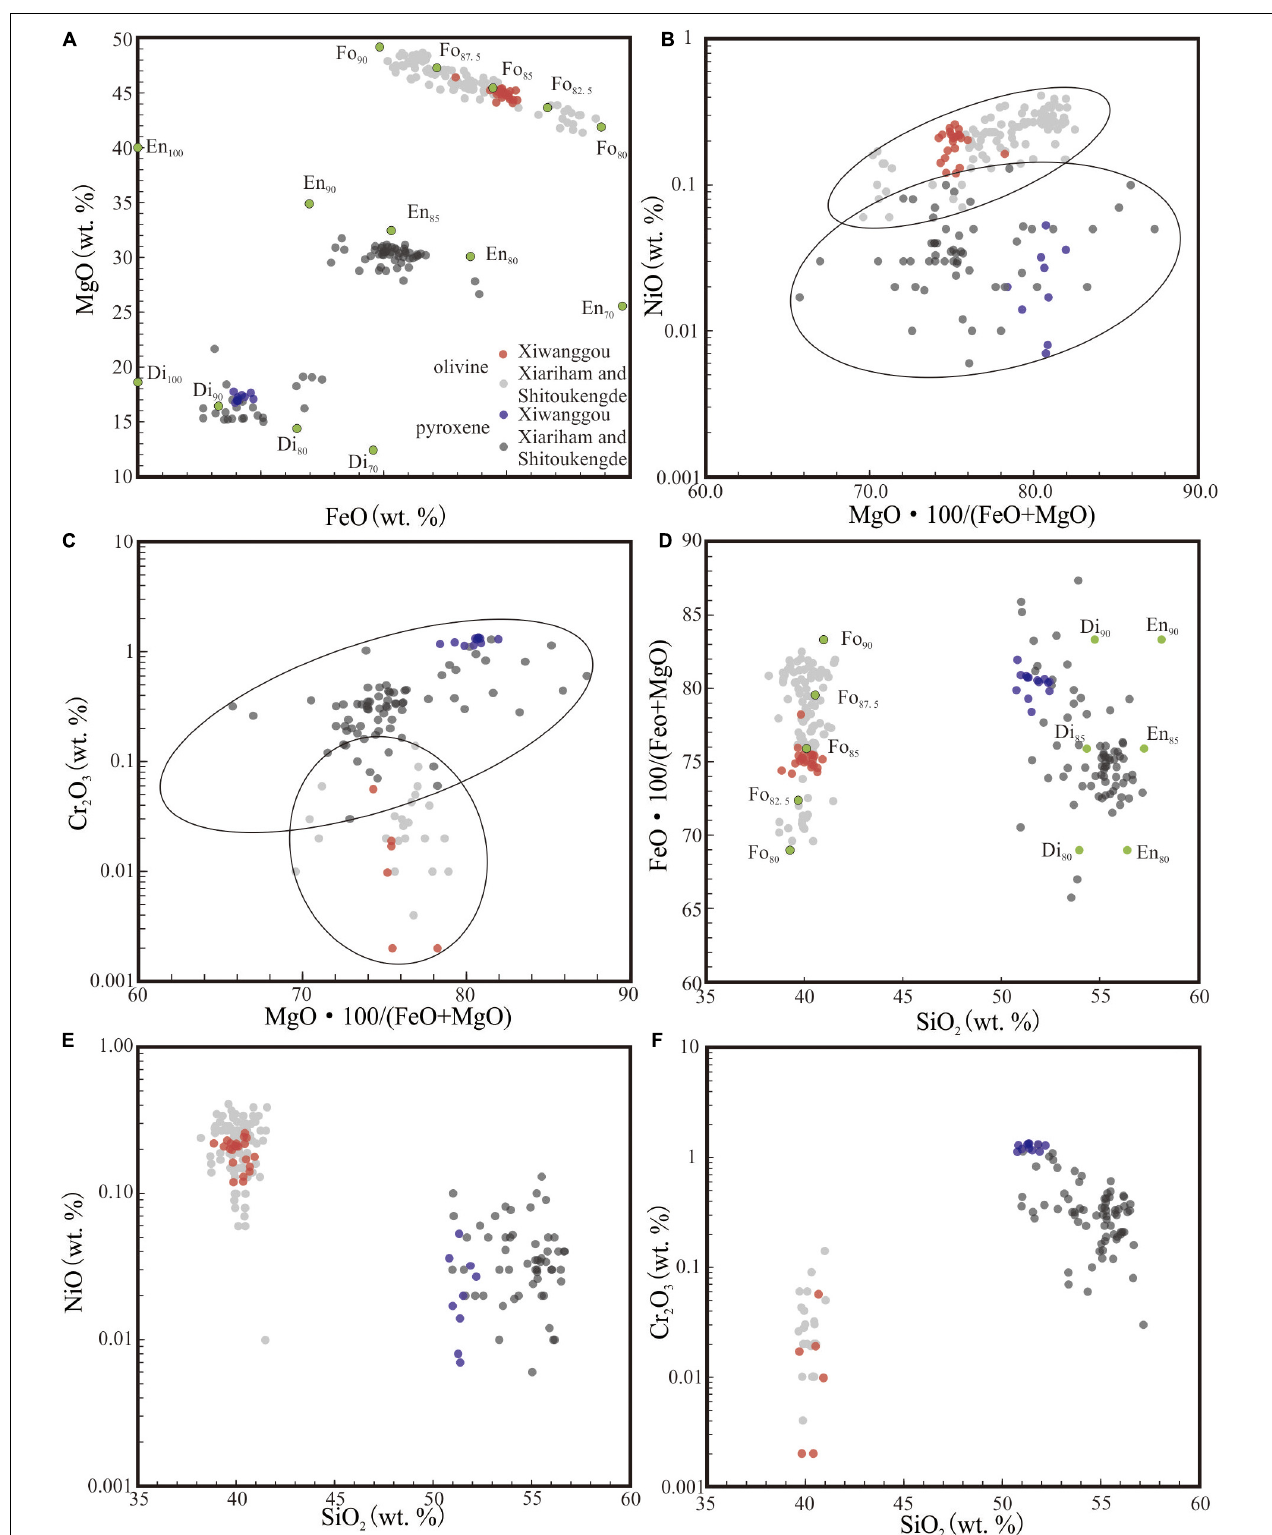
FIGURE 7 | Geochemical diagrams of olivine (A,B) and pyroxene (C–F) compositions. The blue circles are from the Xiwanggou mafic-ultramafic rocks, and the gray ones from the Xiarihamu and Shitoukengde basic–ultrabasic complexes.